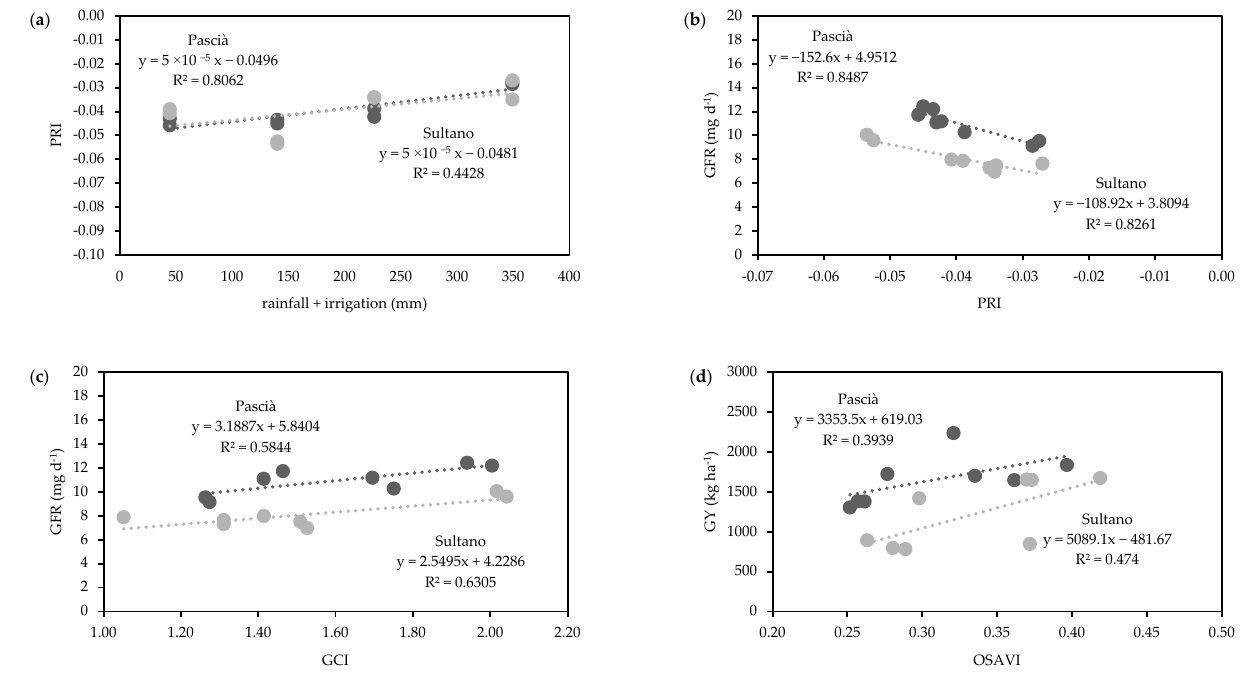
Figure 4. ( a ) Relationship between PRI, measured at grain filling, and water supply (rainfall and irrigation), and ( b ) with grain filling rate; ( c ) relationship between GCI, measured at flowering, with grain filling rate (GFR); ( d ) relationship between OSAVI, measured at grain filling, with grain yield. Chickpea genotypes Pascià and Sultano are reported in deep grey and light grey, respectively.